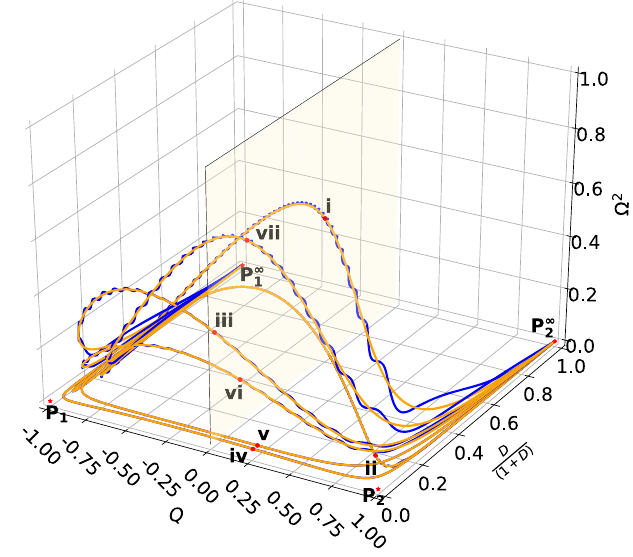
Fig. 20 Some solutions of the full system (93) (blue) and time-averaged system (127) (orange) for the KS metric when γ = 2 in the projection Σ =